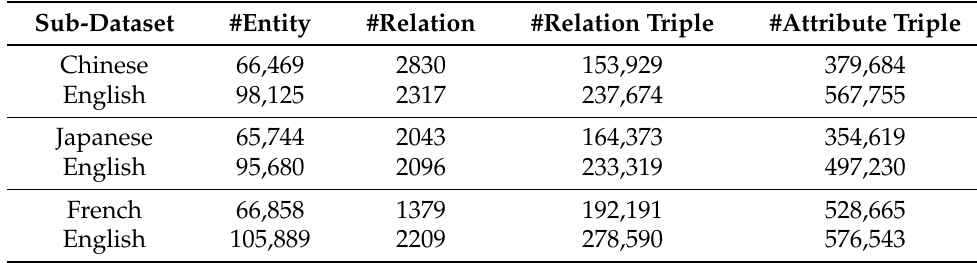
Table 1. The details of the DBP15K